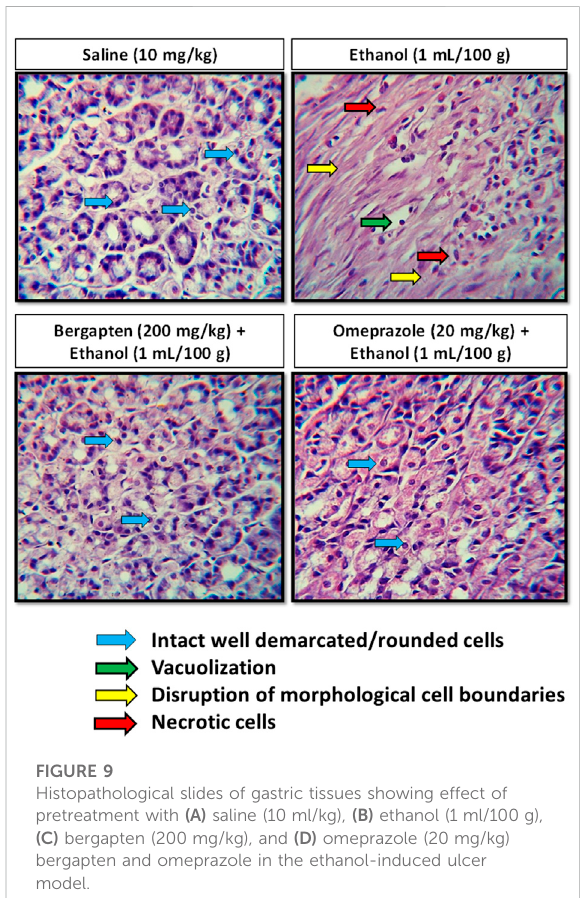
FIGURE 9 Histopathological slides of gastric tissues showing effect of pretreatment with (A) saline (10 ml/kg), (B) ethanol (1 ml/100 g), (C) bergapten (200 mg/kg), and (D) omeprazole (20 mg/kg) bergapten and omeprazole in the ethanol-induced ulcer